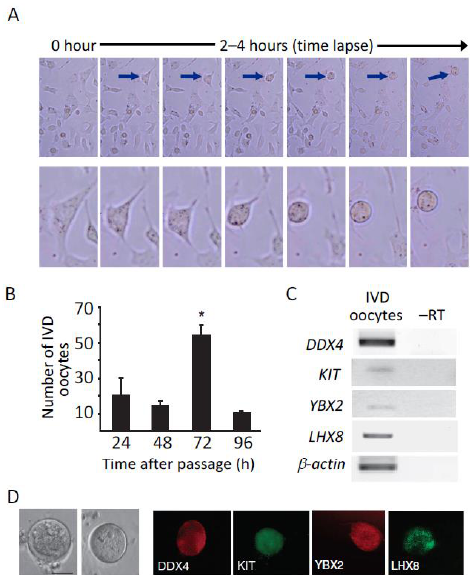
Figure 2. In vitro oogenesis from human OSCs. ( A ) Time lapse images of human OSCs in culture, with a typical OSC (blue arrow) followed as it undergoes progressive differentiation into an IVD oocyte (oocyte-like cell). ( B ) Numbers of IVD oocytes formed in human OSC cultures over time post-passage. ( C ) Expression analysis of germ cell ( DDX4 ) and oocyte ( KIT oncogene or KIT ; Y-box protein 2 or YBX2 , also referred to as MSY2 or CONTRIN ; LIM homeobox protein 8 or LHX8 ) marker genes, as well as of β -actin expression as a loading control, in IVD oocytes collected from human OSC cultures (–RT, PCR analysis performed on the RNA template without reverse transcription, as a control to rule out genomic DNA amplification). ( D ) Representative images of human IVD oocytes by light microscopy (two left panels; scale bar, 50- µ m), and by immunofluorescence microscopy for the presence of DDX4, KIT, YBX2 and LHX8 proteins. Portions of this figure were adapted with permission from White et al. [73].